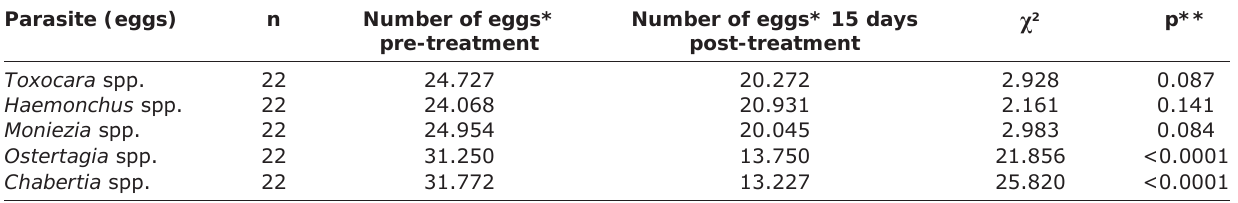
χ 2 p** Number of eggs* 15 days pre-treatment post-treatment